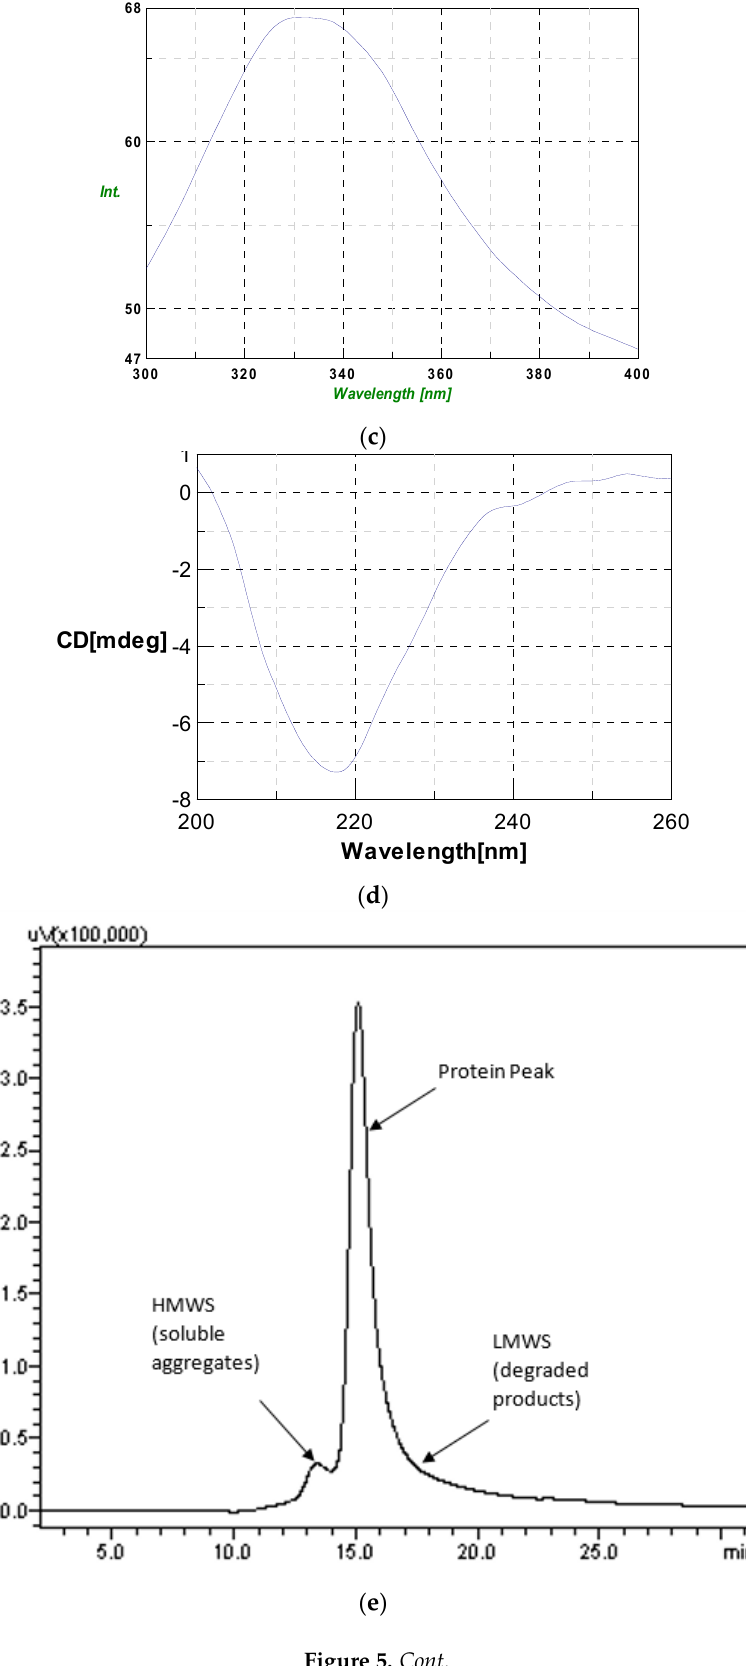
Figure 5. Cont. Figure 5.